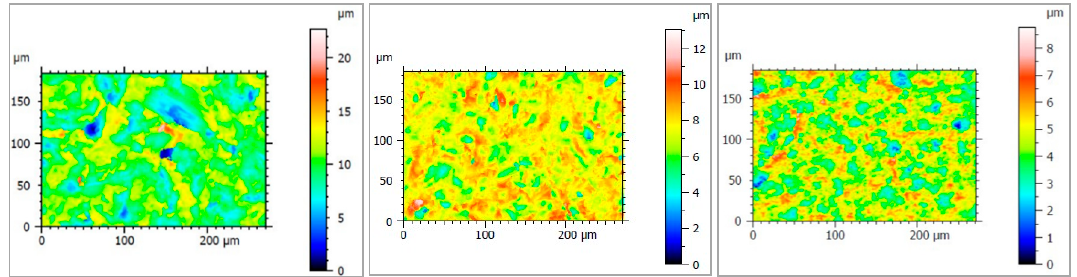
Figure 15. Color map of surface roughness in SLA ( left ), HA/TCP ( middle ), and HA + AW ( right ).